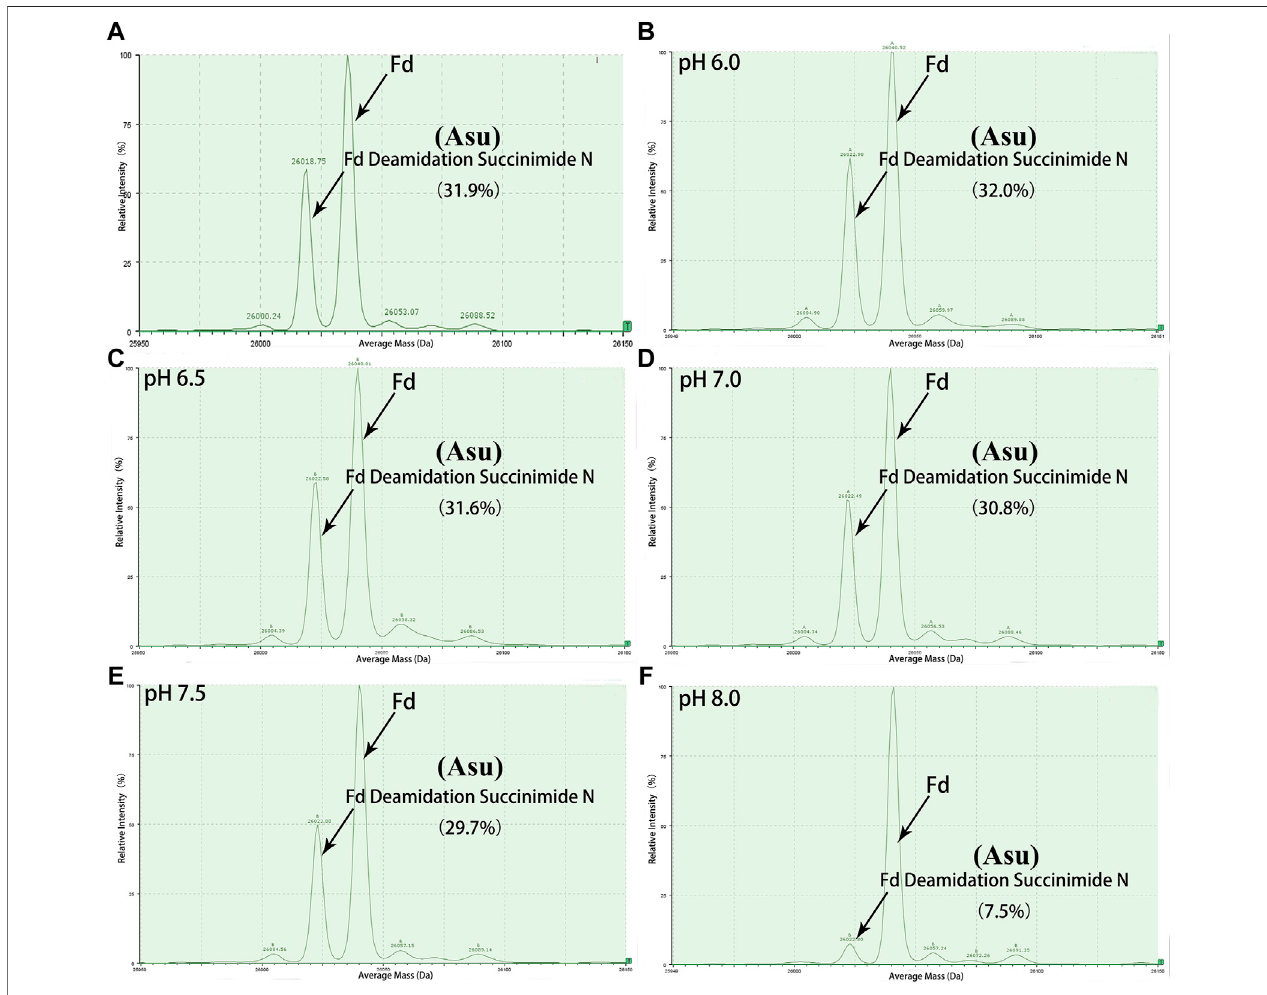
FIGURE 3 | Deconvoluted mass spectrum of golimumab Fd treated with buffers of different pH. An unexpected peak in Fd was relatively stable in the pH range of 6.0 – 7.0 and decreased rapidly as pH increased from 7.5 to 8.0. (A) control, (B) denaturation of the sample at pH 6.0, (C) denaturation of the sample at pH 6.5, (D) denaturation of the sample at pH 7.0, (E) denaturation of the sample at pH 7.5, (F) denaturation of the sample at pH 8.0.